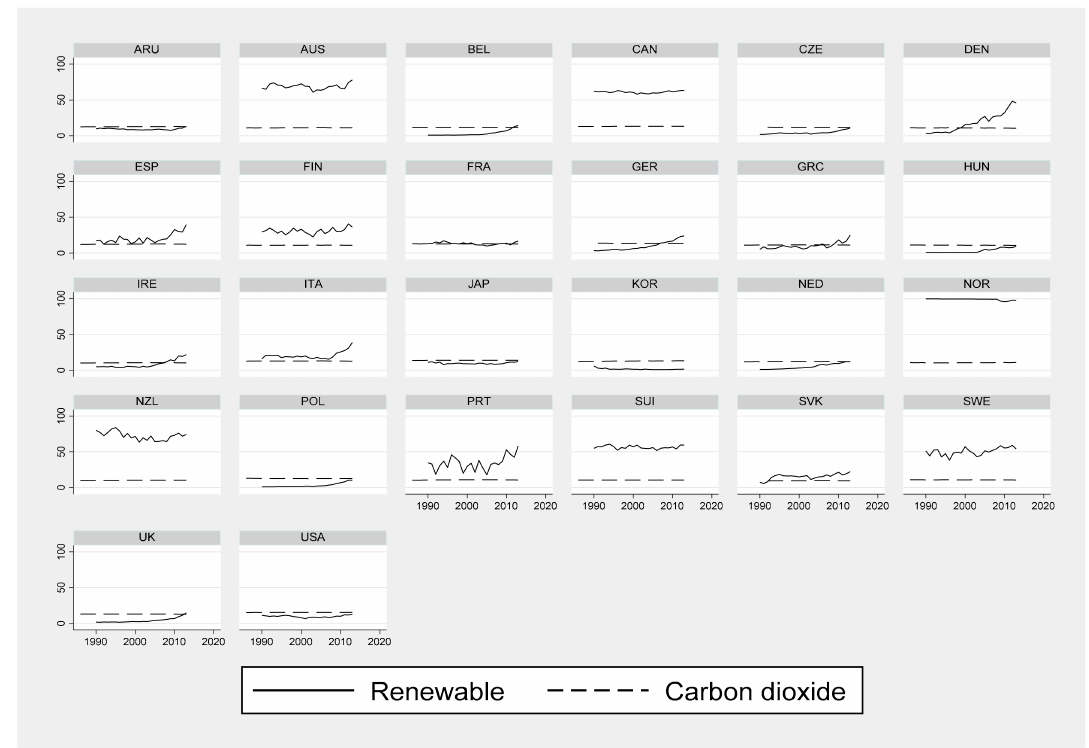
Figure 2. Trends by country in CO 2 emissions and renewable electricity output (from 1987 to